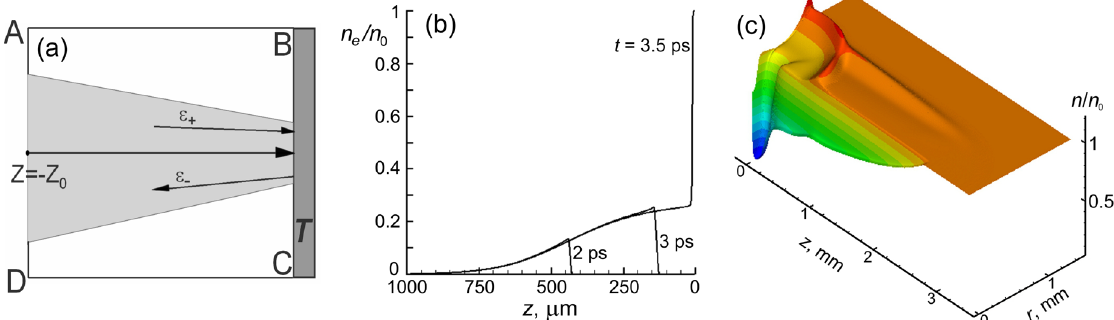
Figure 3. ( a ) Schematic representation of the computational region for the problem of laser beam propagation and reflection from a metallic target. ( b ) The evolution of the ionization degree in argon at the initial pressure of 1.08 bar and temperature of 20 °C during propagation of a 65-fs laser pulse with peak fluence of 3 J/cm 2 at 800 nm wavelength (experimental conditions as in [17,18], loose focusing with f = 20 cm). ( c ) Calculated density distribution of argon for the conditions of ( b ). A complicated wave structure is seen with a quasi-cylindrical compressive wave propagating radially outward the laser beam axis ( r = 0) and a stronger half-spherical wave moving away from the irradiation spot on the target. At r = 0 where the hot ambient gas expands radially, a rarefied region is formed (“plasma pipe”). The ablation products have more freedom to move along this “pipe” due to decreased collisional